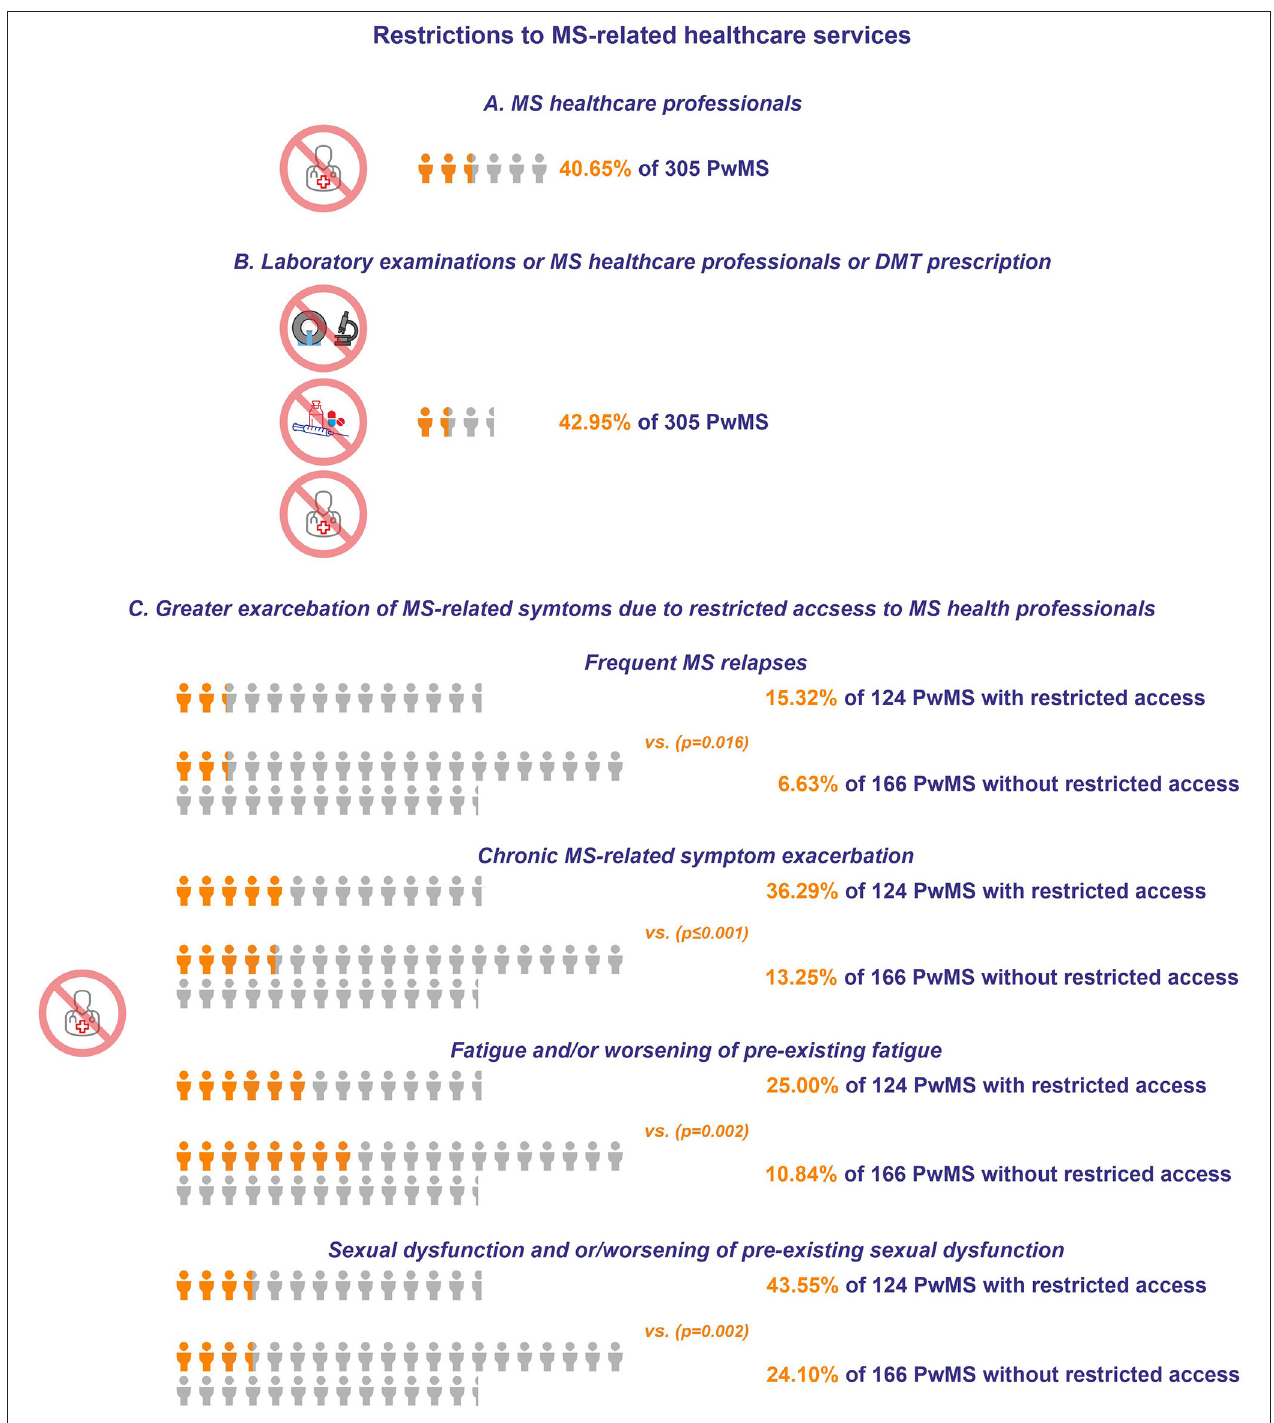
FIGURE 3 | (A) Restrictions to MS healthcare professionals. (B) Restrictions to laboratory examinations or MS healthcare professionals or DMT prescription. The orange icon of human form depicts a significant portion of the respondents who experienced restrictions to MS-related healthcare services, while the light gray icon depicts the total number of respondents. (C) Exacerbation of MS-related symptoms with or without restricted access to MS health professionals. The orange icon of human form depicts the percentage of the respondents with exacerbation of MS-related symptoms, while the light gray icon depicts the total number of PwMS.